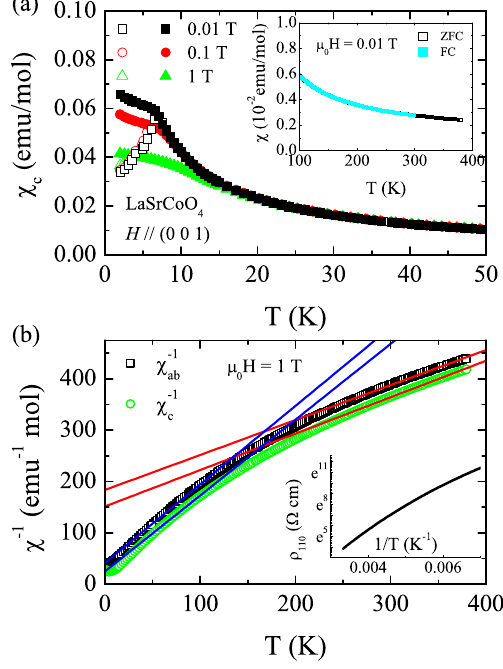
Figure 3. (Color online) ( a ) Magnetic susceptibility of our LaSrCoO 4 single crystals measured with applied magnetic field of 0.01, 0.1, and 1 T along the [0 0 1]-direction ( T < 50 K). The inset shows the entire measured temperature range for µ 0 H = 0.01 T, and indicates the absence of typical ferro-/ferri-magnetic impurity phases or intergrowths. Open and solid symbols represent the zero-field-cooled (ZFC) and FC measurements, respectively. ( b ) Temperature dependence of the inverse magnetic susceptibility χ − 1 c and χ − 1 with magnetic field along the [0 0 1]- and [1 1 0]-direction, ab respectively. The red curve is a fit to the Curie–Weiss (in the range of 250 K and 380 K), whereas the blue curve is a corresponding fit in the range of 50 K to 100 K. The inset shows the temperature dependence of the electrical resistivity for a current along the [1 1